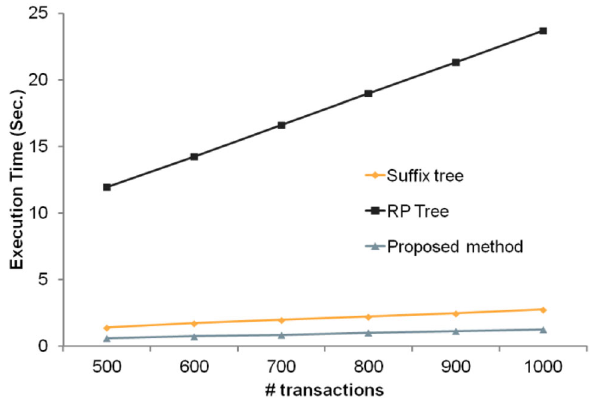
Fig.14 Execution time of the compared methods under different num- bers of transactions